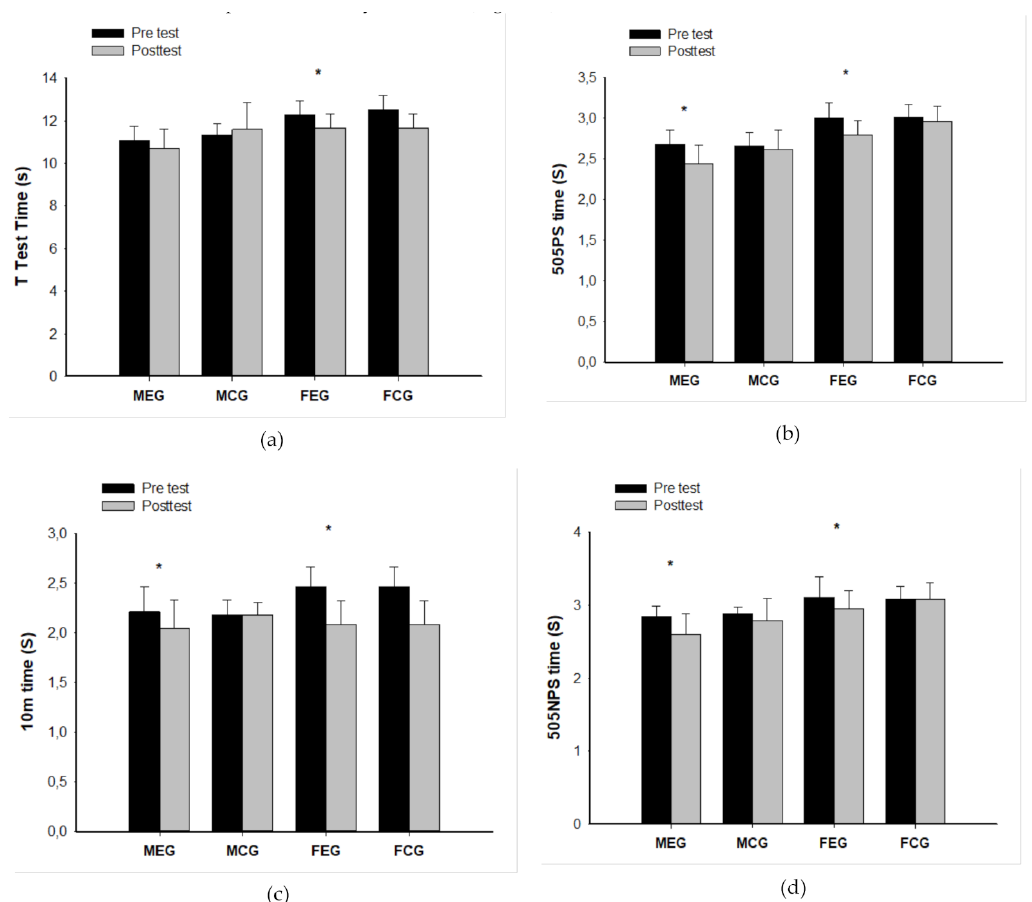
Figure 1. Differences between pre and post-test in ( a ) T-test, ( b ) 505 Preferred Side (PS), ( c ) 10 m time, and ( d ) 505 Non- Preferred Side (NPS) in male and female players. Legend: MEG: Male experimental group; MCG: Male control group; FEG: Female experimental group; FCG: Female control group. * p ≤ 0.05. Regarding the % of change in each variable, no differences were found between male and female players (all p ≥